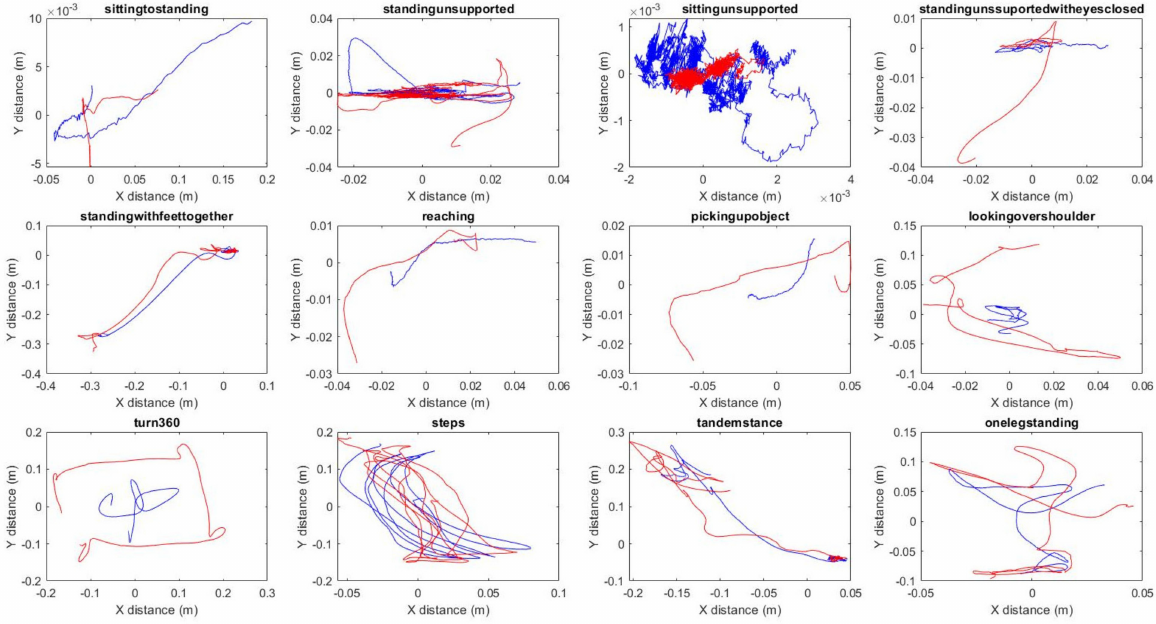
Figure 3. Task data of one of the subjects completing the VR-BBS, the blue line represents the COM and the red line the HTC Vive tracker trajectory.